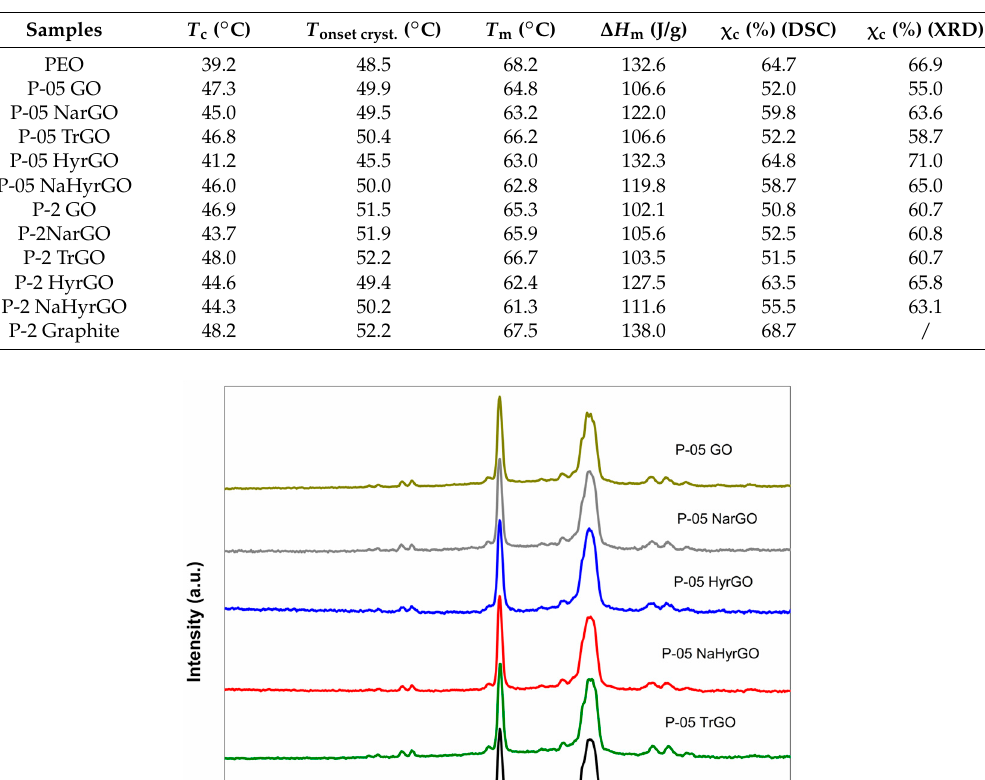
Table 1. Thermal properties of PEO-based nanocomposites.